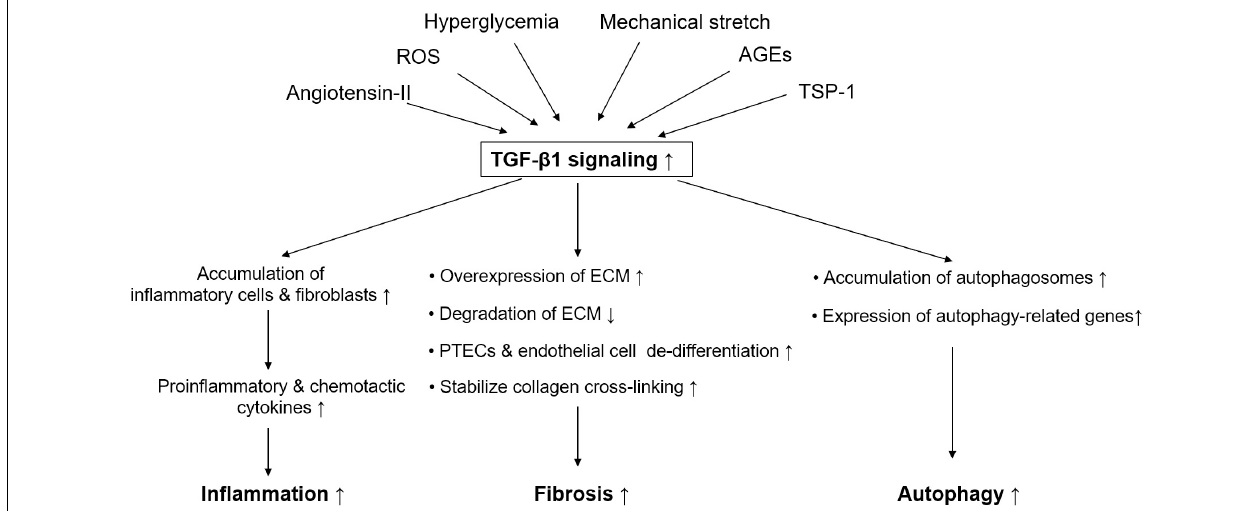
FIGURE 1 | Simplified schematic diagram of pathological role of TGF- β 1 signaling in diabetic kidney disease. Pathogenic stimuli in diabetic kidney disease like hyperglycemia, angiotensin-II, reactive oxygen species, mechanical stretch, advanced glycation end products, and thrombospondin-1 are able to active TGF- β 1 signaling. TGF- β 1 signaling plays an important role in mediating renal fibrosis, inflammation, and autophagy in proximal tubular epithelial cells in diabetic kidney disease. TGF- β , transforming growth factor-beta; ROS, reactive oxygen species; PTECs, proximal tubular epithelial cells; AGE, advanced glycation end products; TSP-1, thrombospondin-1; ECM, extracellular